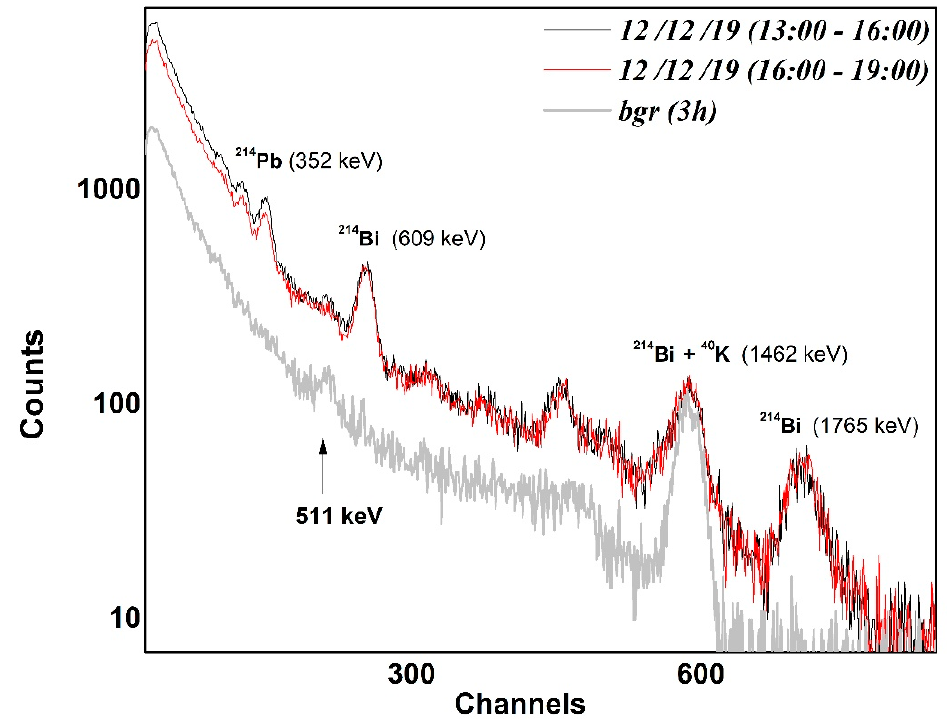
Figure 3. The background spectrum without rainfall and two spectra with rainfall. The acquisition period was 3 h.